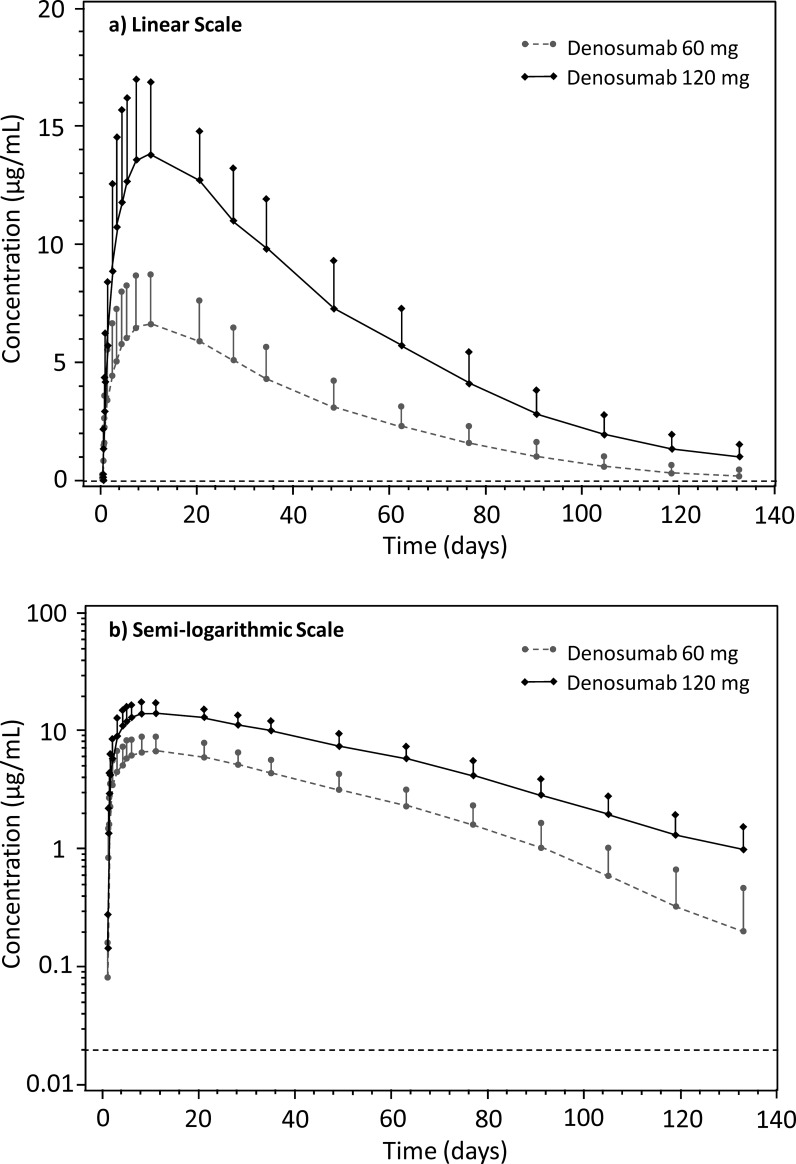
Mean serum concentration-time plot of denosumab following single subcutaneous administration at doses of 60 mg and 120 mg.Error bar represents standard deviation.